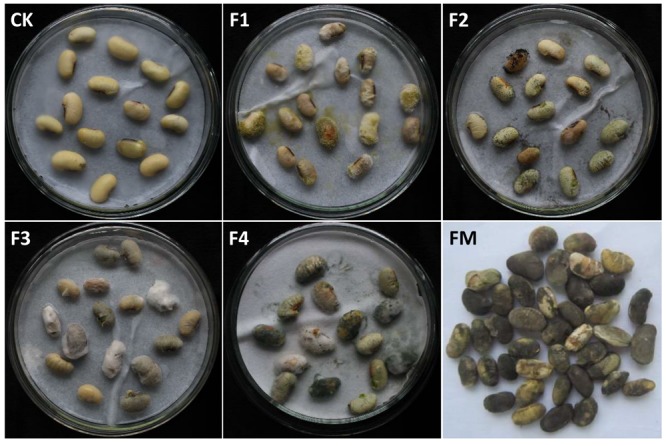
The mildew phenotype of soybean grains re-inoculated with field-derived fungi. CK: sterile water; F1: A. flavus; F2: A. niger; F3: F. moniliforme; F4: Penicillium, FM: grains naturally fungus-infected in the field.